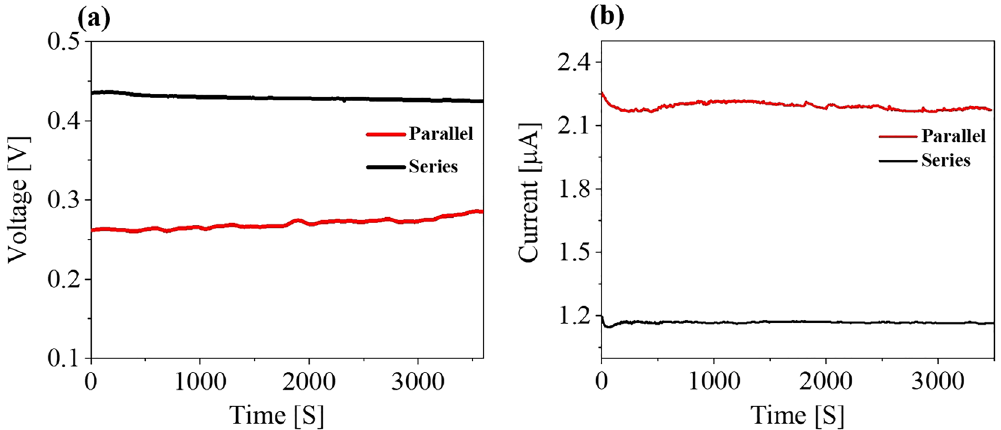
Figure 5. ( a ) Voltage and ( b ) Current generated by two alumina samples in series and parallel connections.